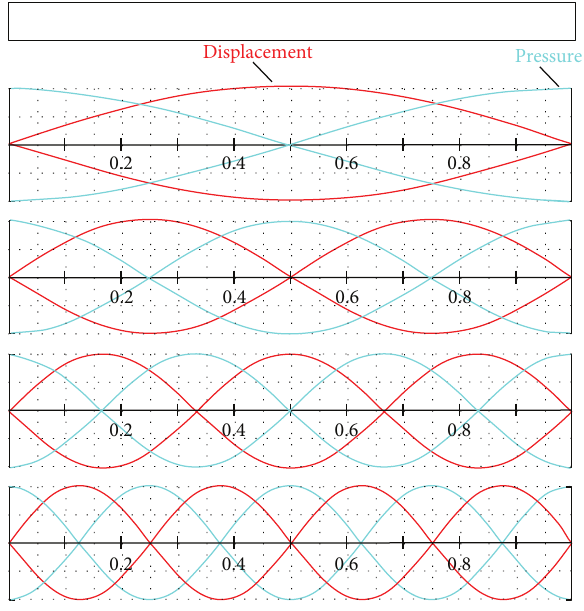
Figure 2: Standing wave in a pipe closed on both sides.